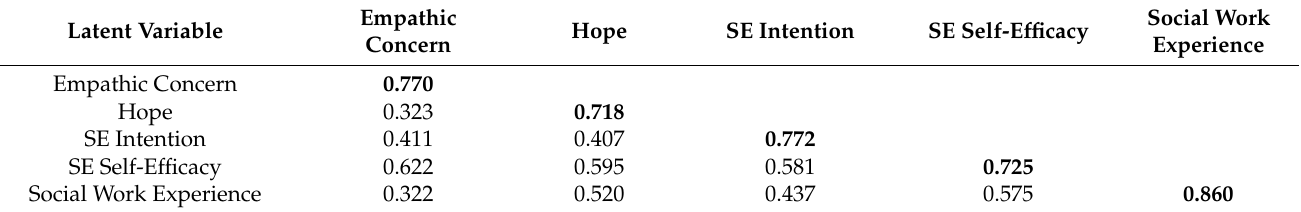
Table 4. Fornell–Larcker Criterion.